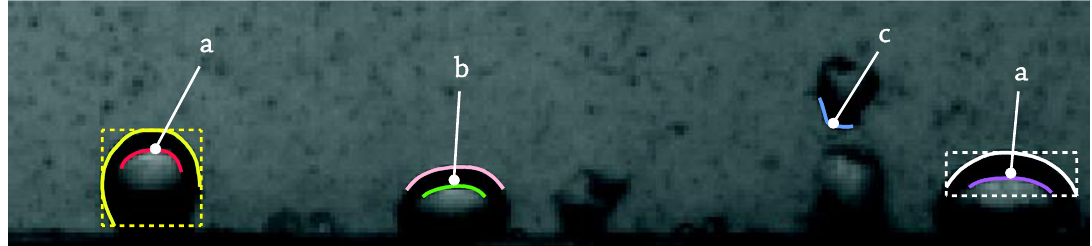
Figure 9. Discarding criteria in side projection: ( a ) inscribed discarded edges; ( b ) bubble due to the green edge will be outlined, but rejected in the final discarding process; ( c ) straight discarded edge.